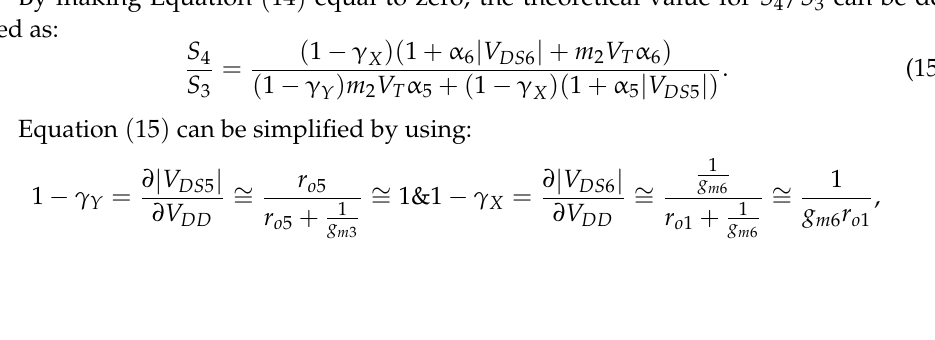
Figure 5. Line sensitivity depending on the width of M4. 3.5. Line Sensitivity To deal with the impact of possible process and mismatch variations on the LS, the proposed design adopts a trimming block, as shown in Figure 6. The trimming circuit allows the digital adjustment of the bottom current mirror ratio 𝑆 (cid:2872) /𝑆 (cid:2871) , which will adapt